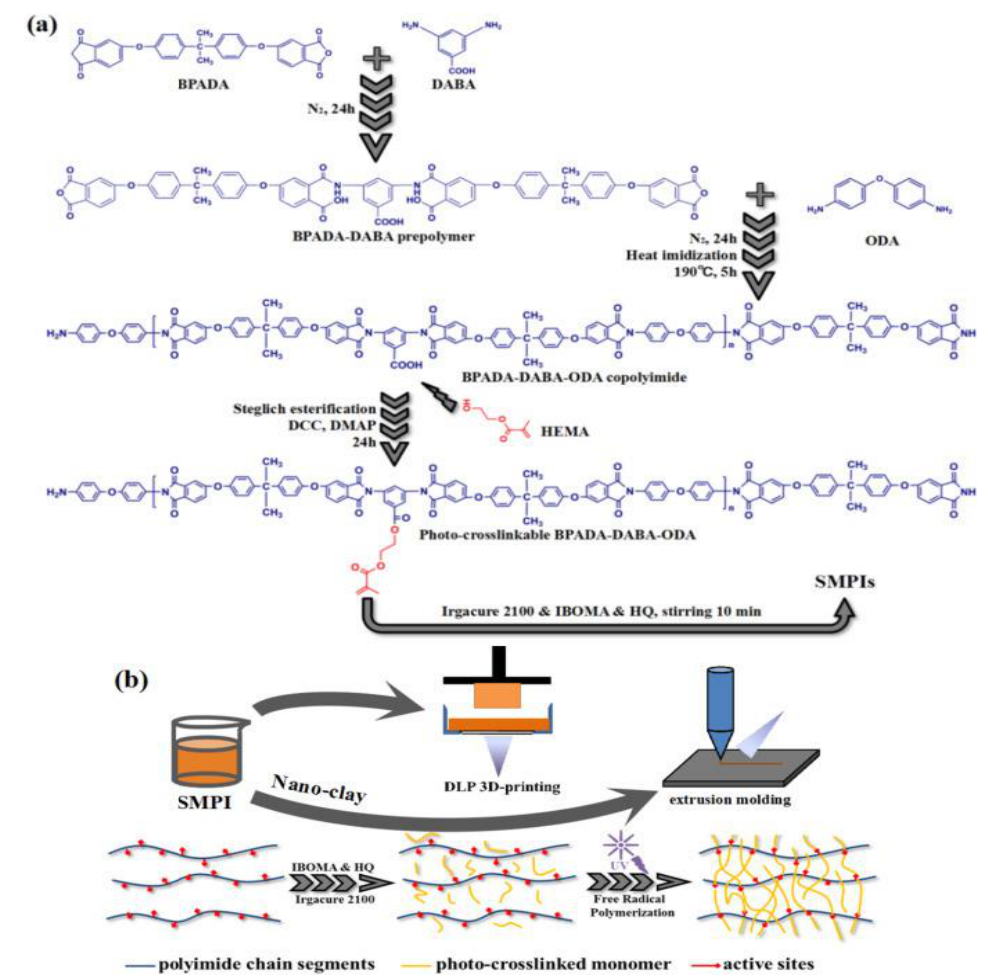
Figure 21. ( a ) A scheme of SMPI network preparation. ( b ) A schematic diagram of 3DP and extrusion moulding process [190]. Copyright © 2022 Elsevier.